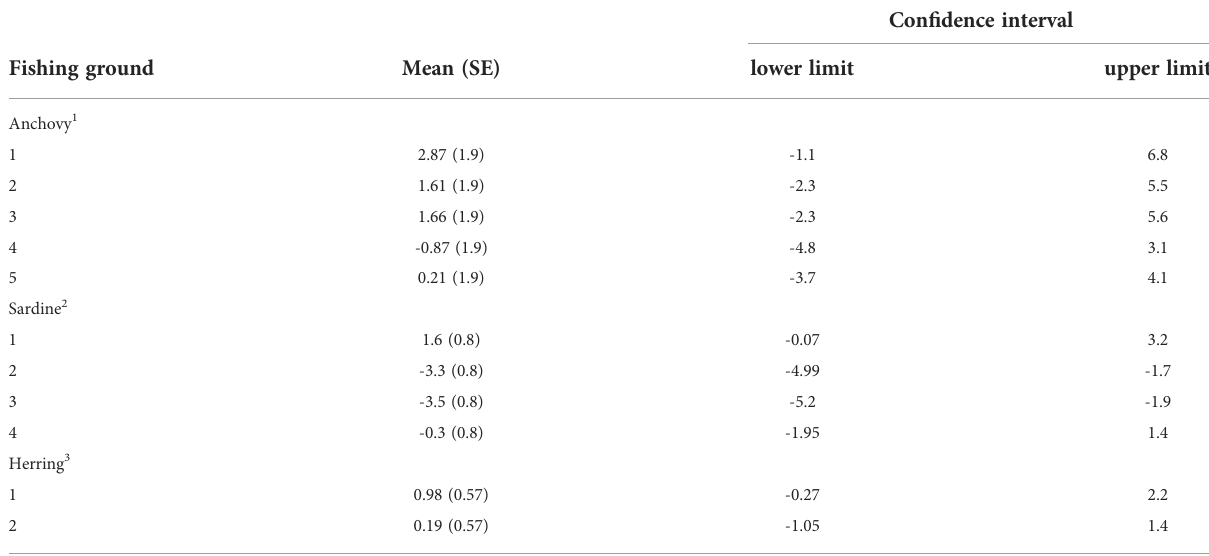
Trend (slope of the linear regression) Con fi dence interval